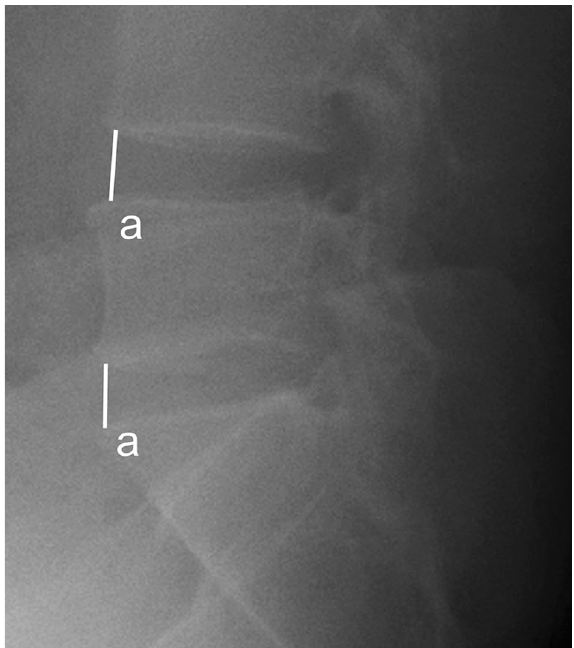
Figure 1. Anterior disc height (ADH): ADH was measured as the distance between the most anterior point of the upper and lower endplates.